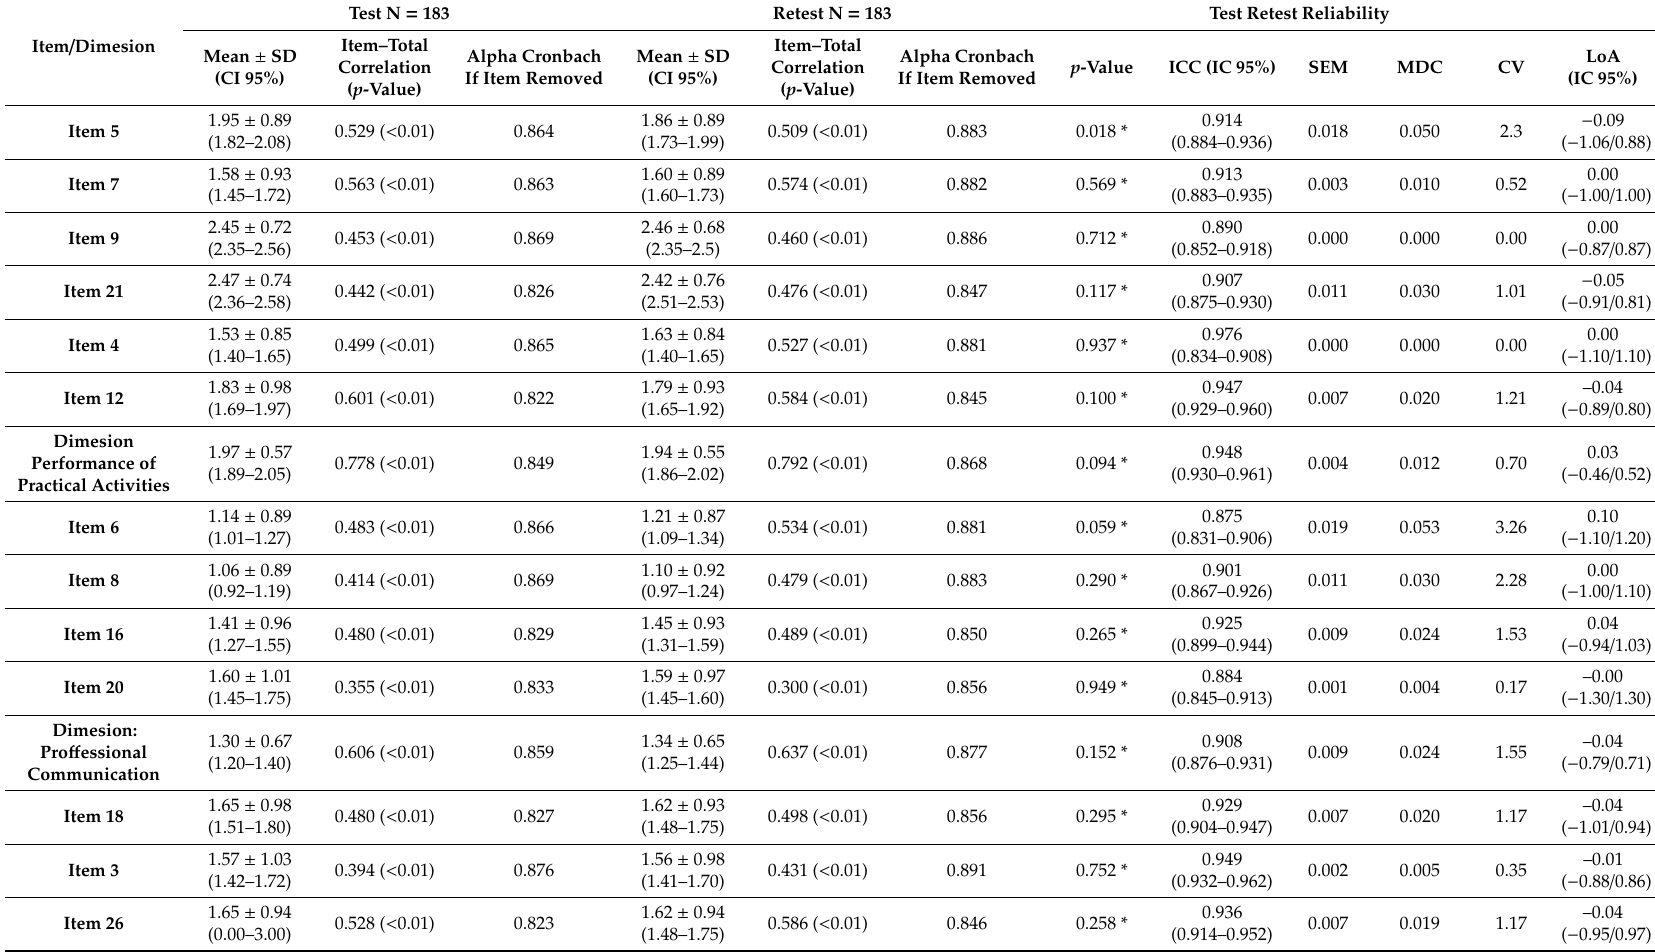
Table 1. Results of reliability, reproducibility and systematic di ff erences for the Assessment of Stress in Podiatry Students